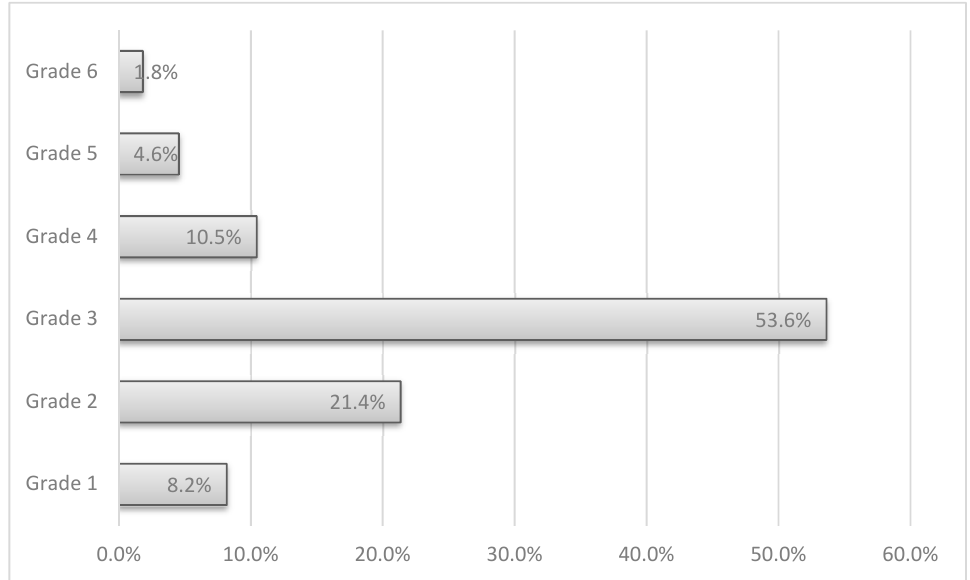
Figure 1. Adverse Events severity grade distribution. Graph shows the distribution of AEs by grades according to SAVES v2 system. “Grade 3” AEs are the most common in our cohort: 53.6% of events are likely to have a temporary effect on